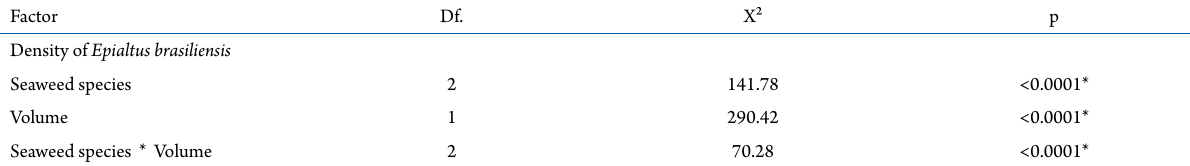
Table 1. Epialtus brasiliensis density between the seaweed Sargassum cymosum, Hypnea musciformis and Acanthophora spicifera , according to GLM analysis. Density of E. brasiliensis was compared between treatments, according to the influence of seaweed species (categorical variable) and seaweed volume (continuous variable). Asterisks indicate a significant difference (p < 0.001) according to the GLM analysis.